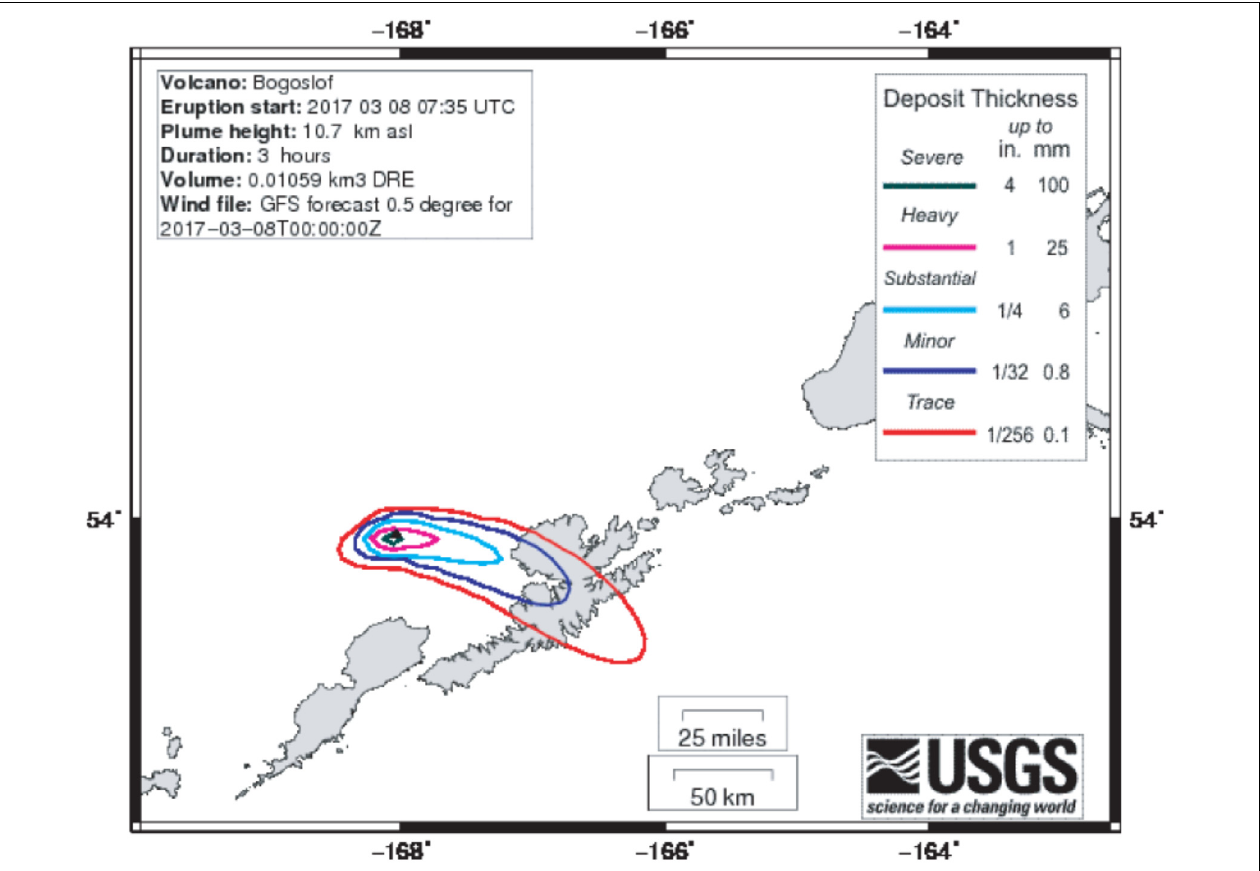
FIGURE 5 | Map with contours of expected ashfall thickness for the March 7, 2017 event (#37) that had ash fallout near Makushin on Unalaska Island. Contours derived from the numerical atmospheric transport model Ash3D (Schwaiger et al., 2012). Please refer to Figure 1 for place